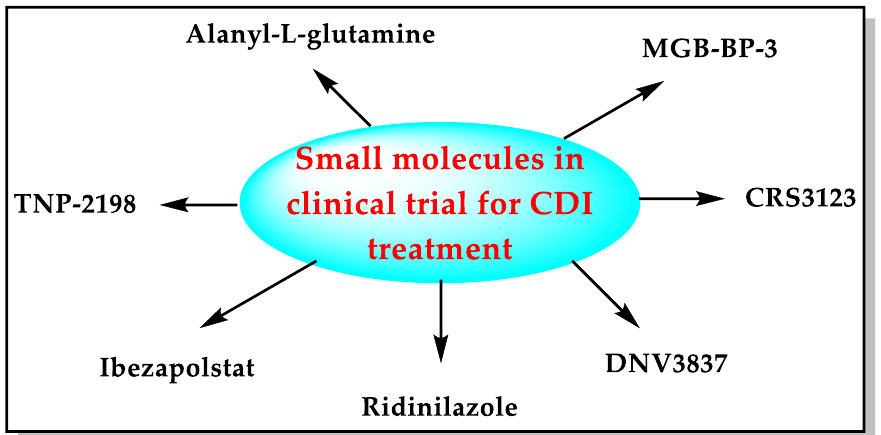
Figure 3. Small molecules in development for CDI treatment.